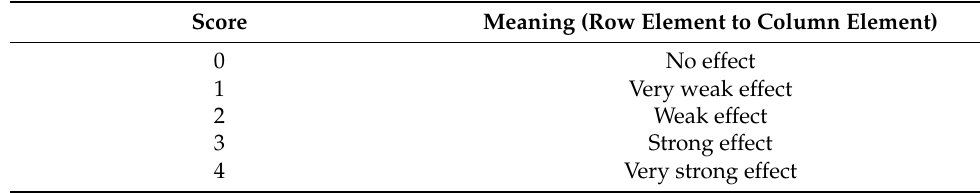
Table 2. Score table of influence